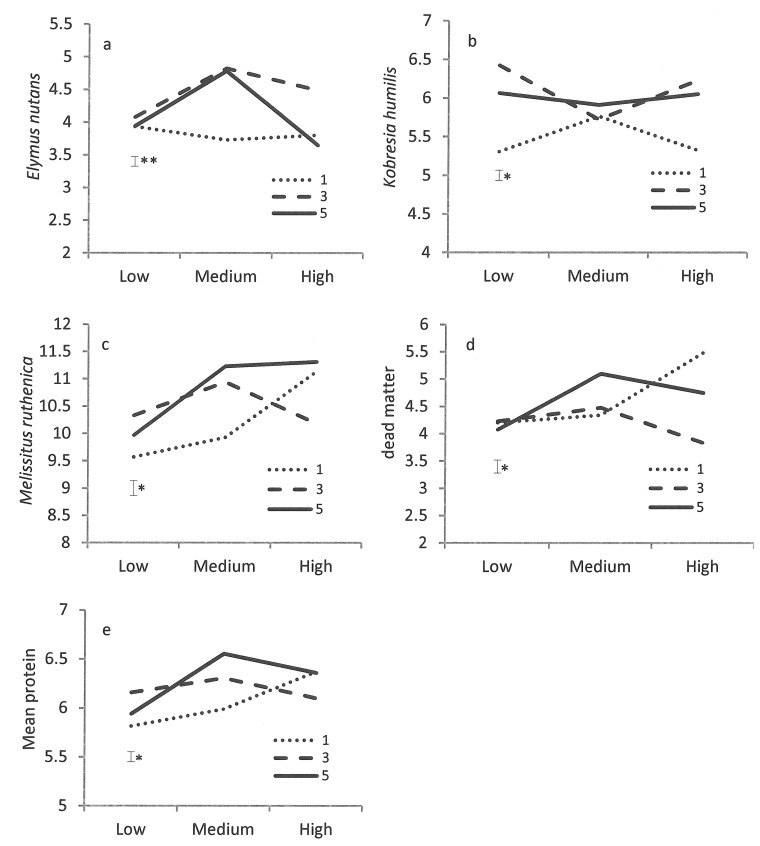
Interactions between defoliation regimes (cut to 1, 3 and 5 cm above ground) and fertiliser application (low, medium and high) on the protein content (%) of (a) Elymus nutans, (b) Kobresia humilis, (c) Melissitus ruthenica and (d) dead matter, and (e) the mean.Bars represent the standard error of the mean; **P < 0.01; *P < 0.05.